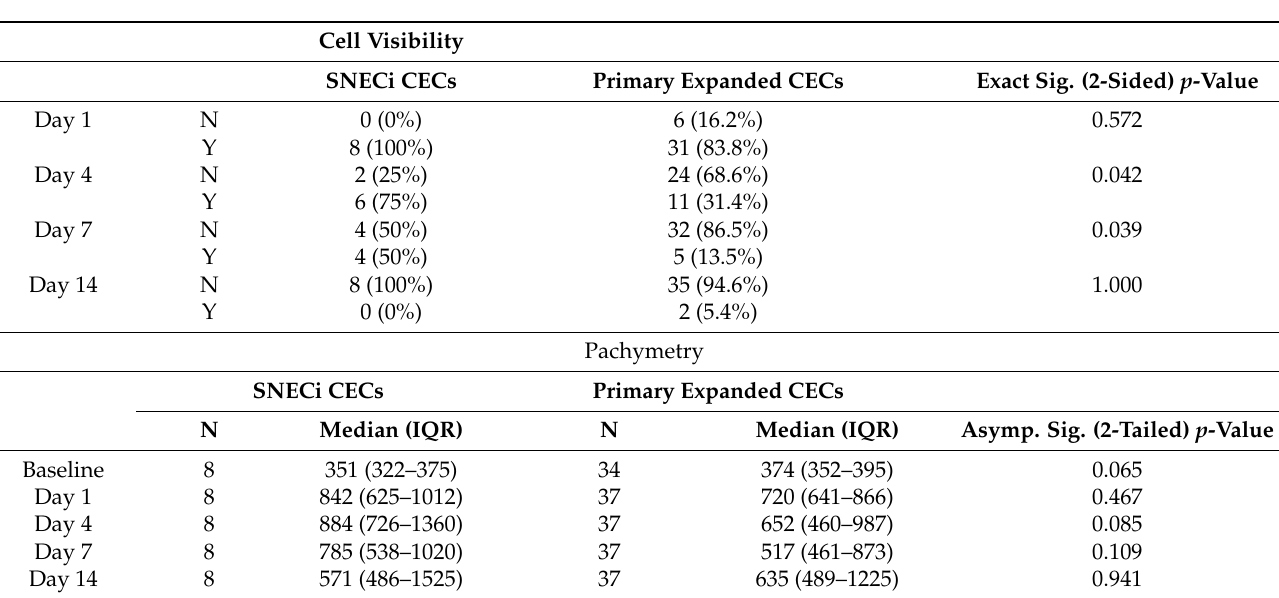
Figure 2. Receiver operating curves (ROC) based on logistic regression modelling using cell visibility and pachymetry data for days 1, 4, 7 and 14. Table 3. Sensitivity analysis comparing eyes receiving primary expanded CECs or SNECi